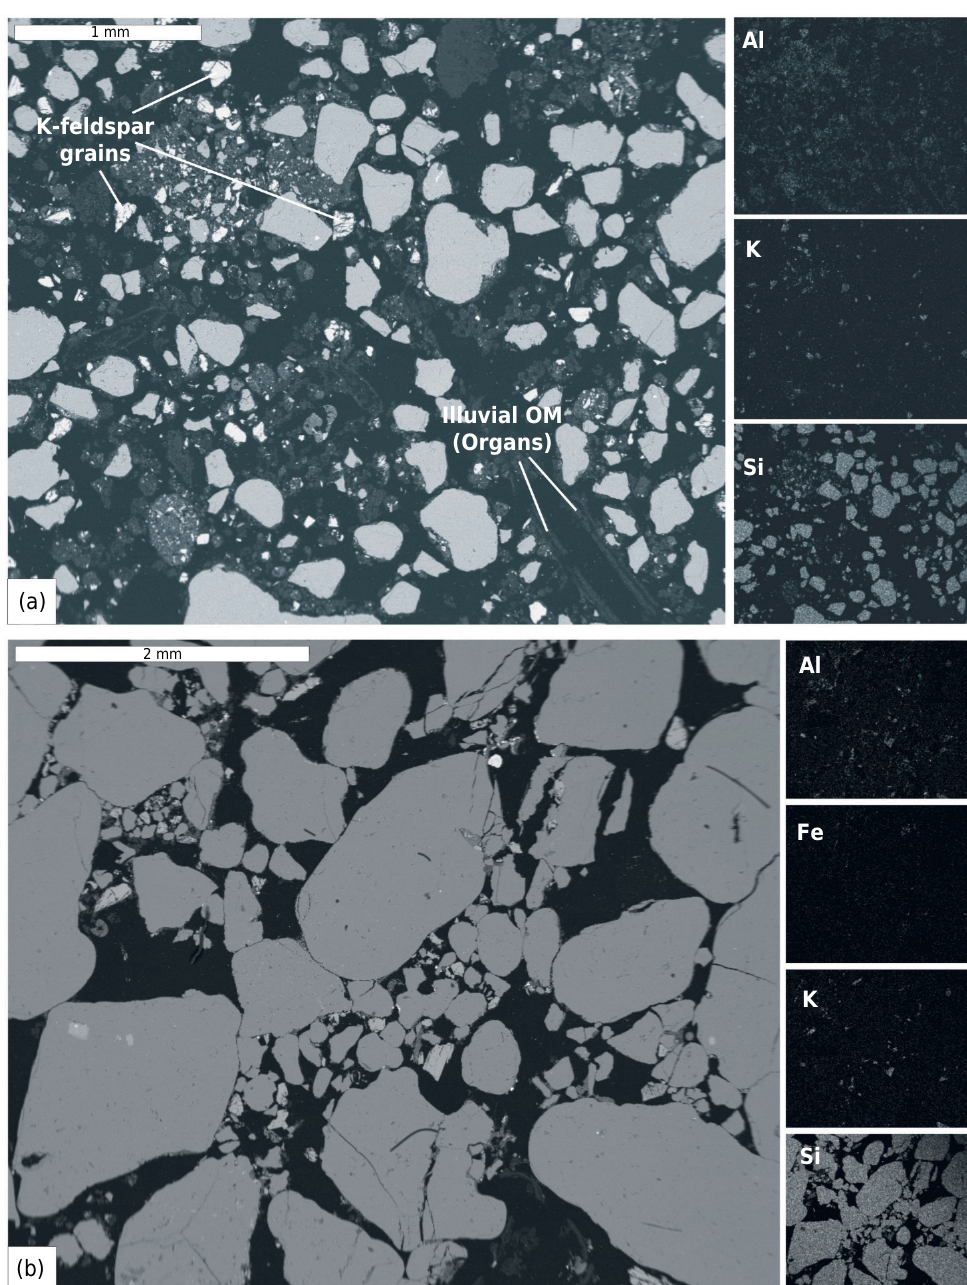
Figure 2. Backscattered electrons images and microchemical maps of pedogenic horizons. (a) P1, Bhs horizon (0.35-0.70 m) with illuvial Al-rich organic matter coating features, and rare K-feldspar grains. (b) P2, C2 horizon (0.70-0.90 m) with Al-rich organic matter, little Fe forms, and rare K-feldspar